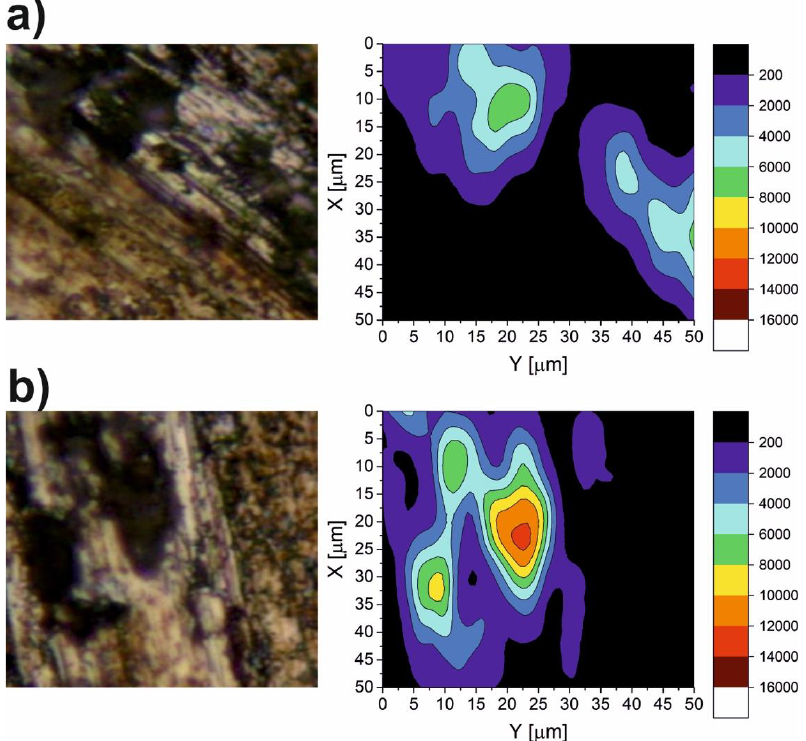
Figure 13. The Raman maps of Ni-10% CaF 2 ( a ) and Ni-20% CaF 2 ( b ) self-lubricating composites after wear test at 400 °C.